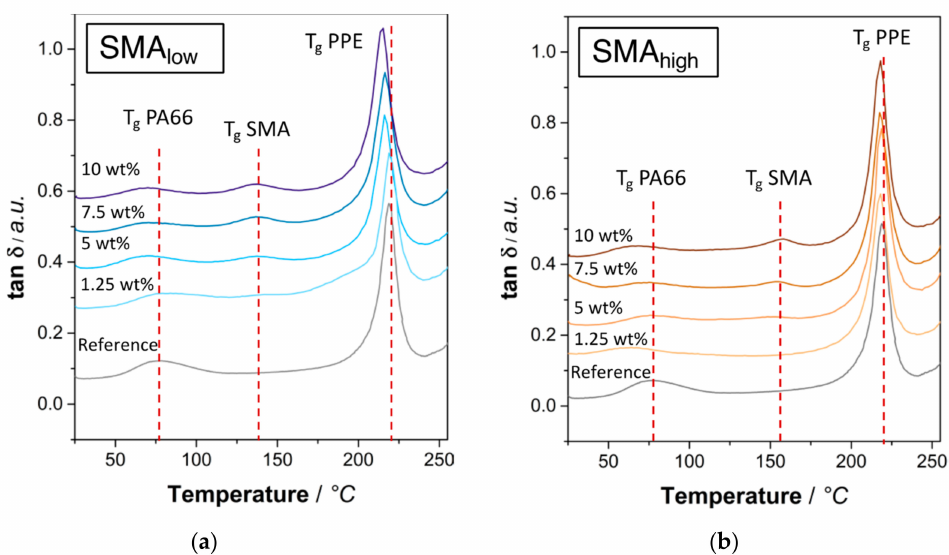
Figure 1. Tan δ plots of SMA compatibilized PA66 / PPE (1:1 w / w) ternary blends with ( a ) SMA low , ( b ) SMA high at various